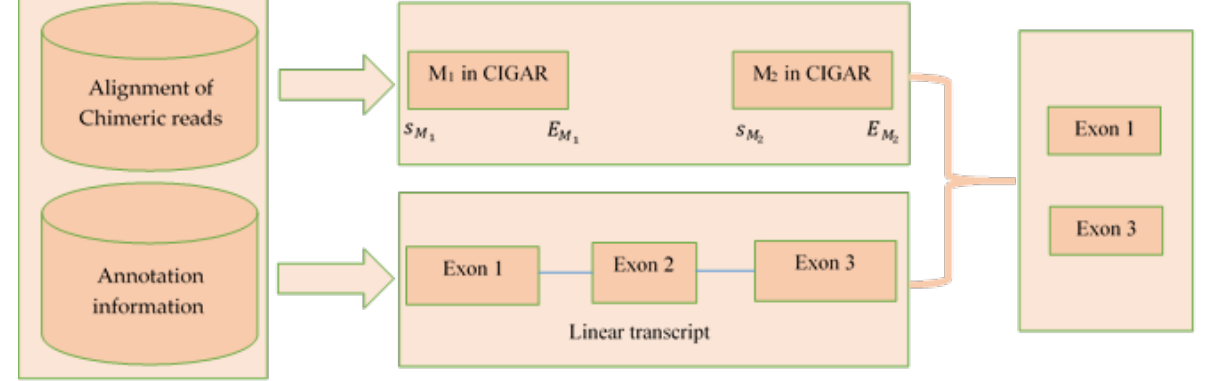
Figure 6. Procedure of extracting exons from the CIGAR string from the alignment of chimeric read.